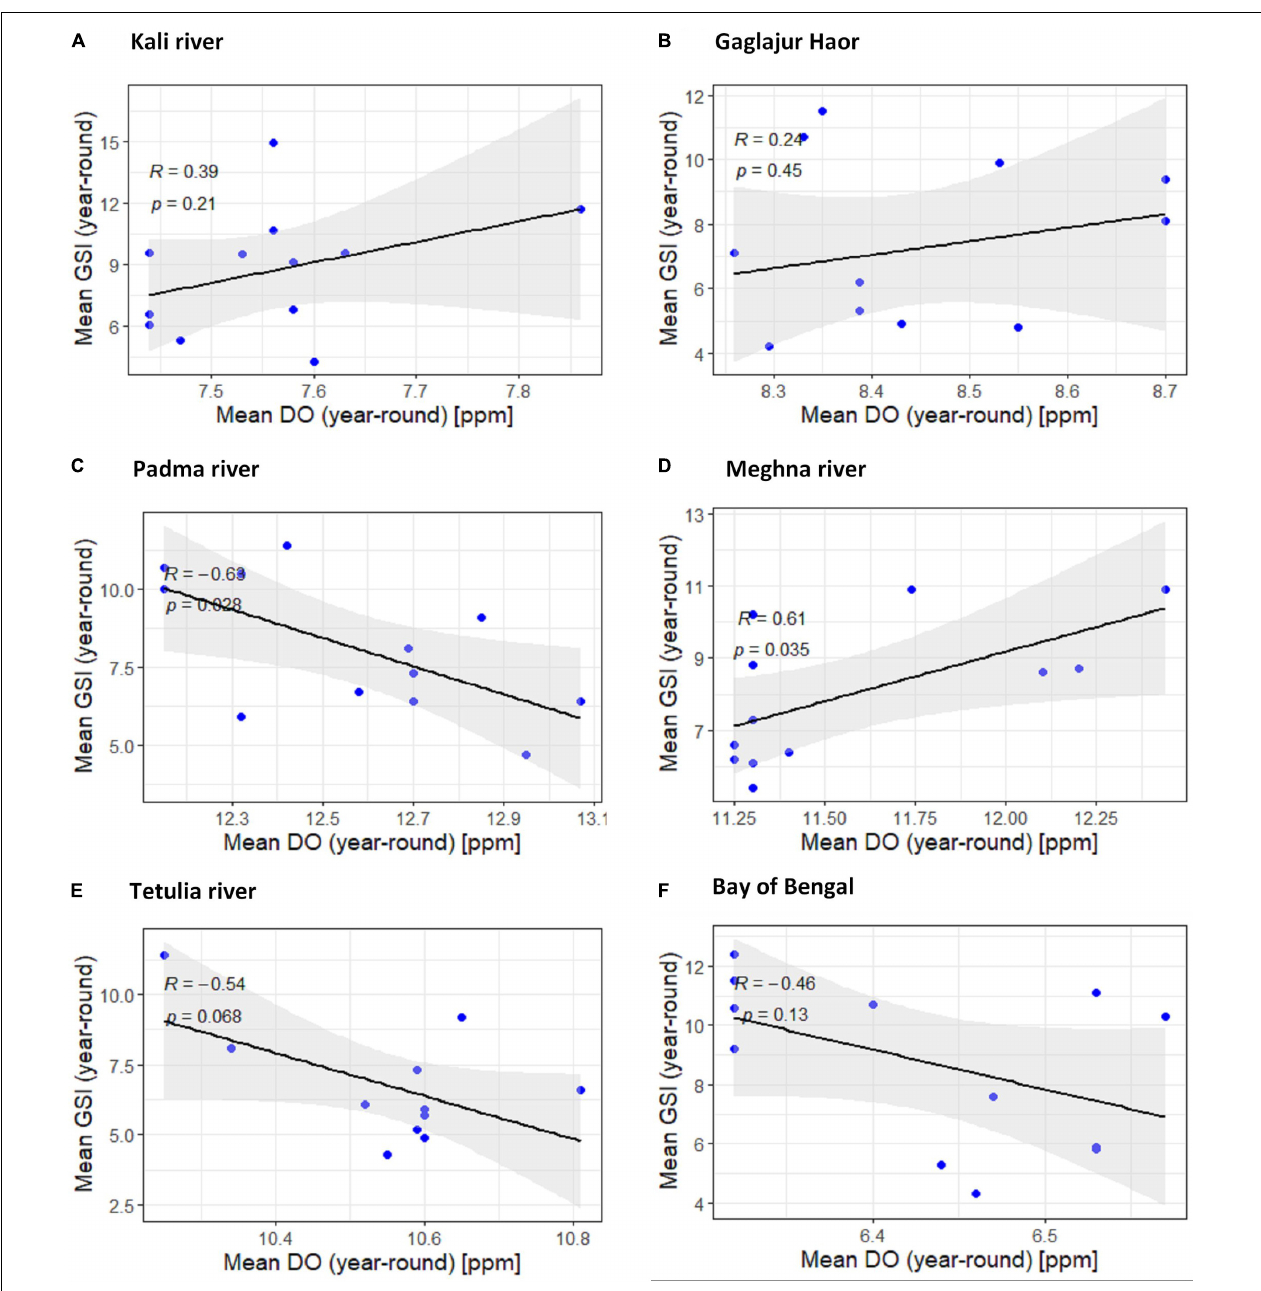
FIGURE 6 | Scatter plot and linear regression for the year-round means of Gonadosomatic index (GSI) of Tenualosa ilisha against mean dissolved oxygen (DO) for six diverse habitats across Bangladesh: (A) Kali river, (B) Gaglajur Haor, (C) Padma river, (D) Meghna river, (E) Tetulia river, and (F) Bay of Bengal. Pearson correlation coefficient is reported as “R” while probability value is reported as